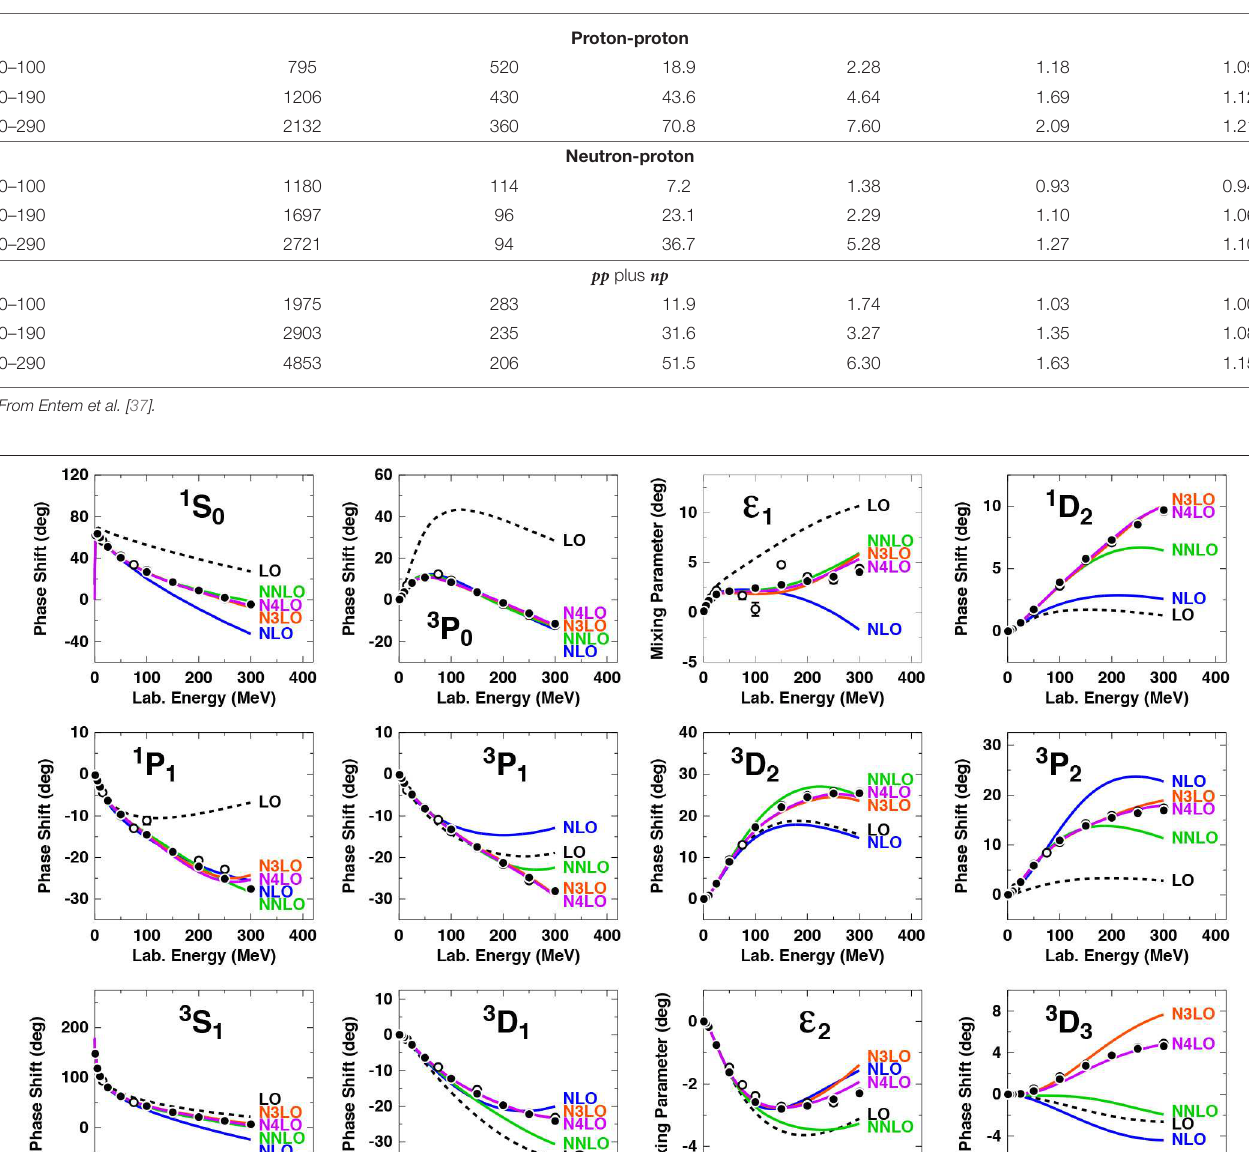
TABLE 4 | χ 2 / datum for the fit of the 2016 NN data base by NN potentials at various orders of chiral EFT ( 3